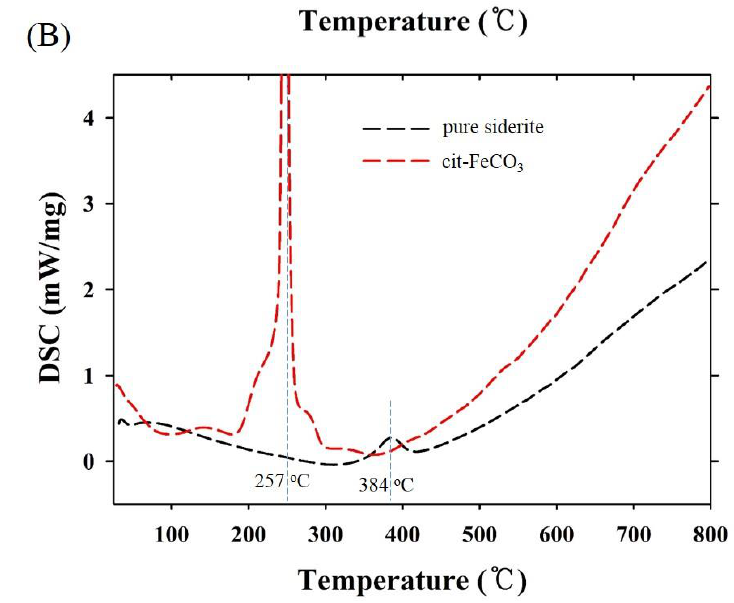
Figure 4. ( A ) Thermogravimetric (TG) and ( B ) differential scanning calorimetry (DSC) profiles of the two CF-NCs synthesized at 0 mM and 5 mM citrate concentration, respectively. Table 1. Chemical composition of the CF-NC samples synthesized in the presence of different citric acid concentrations (0–5 mM).